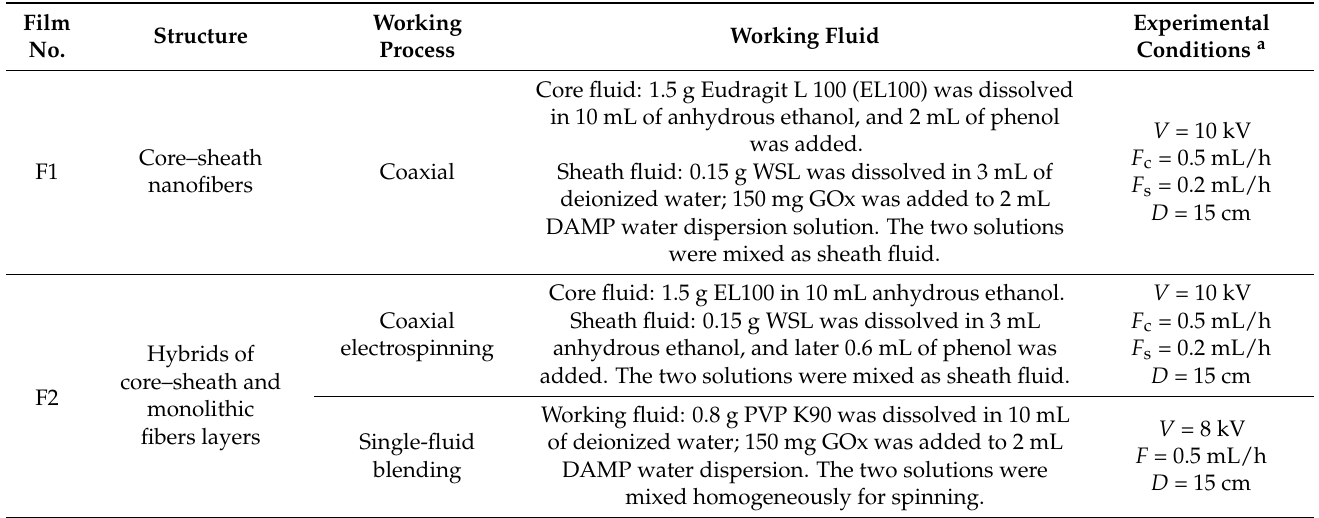
Table 1. The experimental parameters for fabricating the